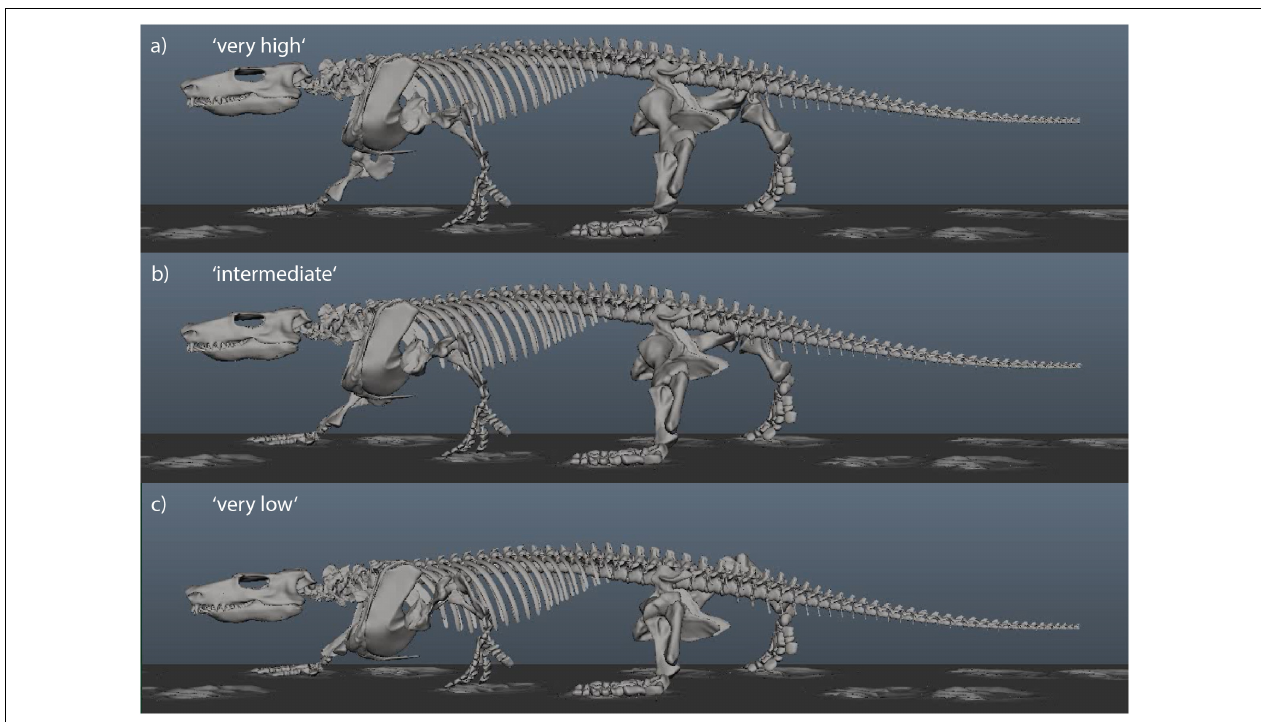
FIGURE 5 | Still images from animated Orobates locomotor cycle to illustrate the experimental variation of body height. Three of five variations are shown. Animation from Nyakatura et al. (2019). (a) “Very high” with IGD = 0.52. (b) “Intermediate” with IGD = 0.45. (c) “Very low” with IGD =